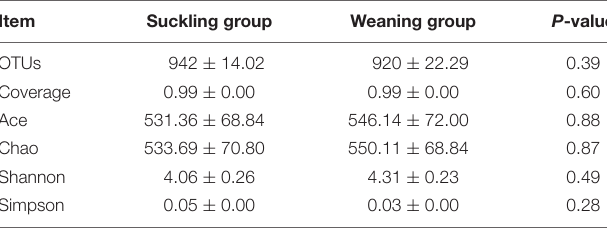
TABLE 1 | Diversity estimation of the 16S rRNA gene libraries from microbiota in the colon of piglets.